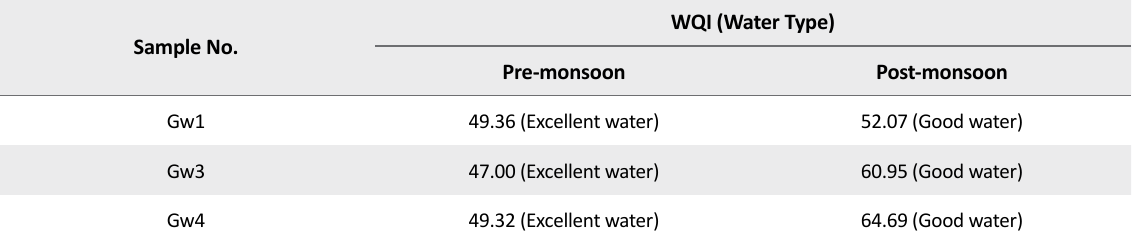
Table 4. Classification of groundwater based on calculated Water Quality Index (WQI)